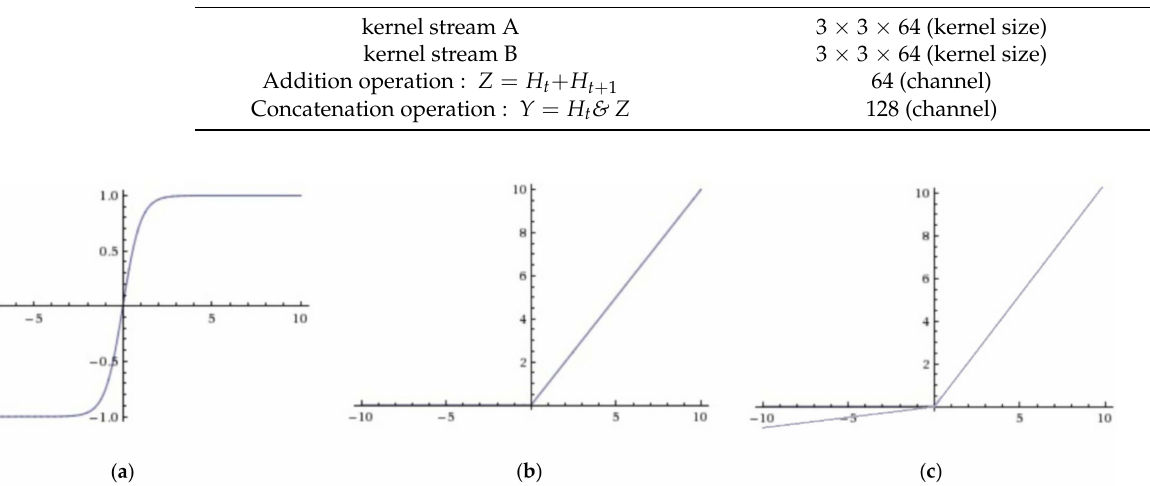
Figure 5. Different activation functions. ( a ) Tanh, ( b ) ReLu, ( c ) Leaky